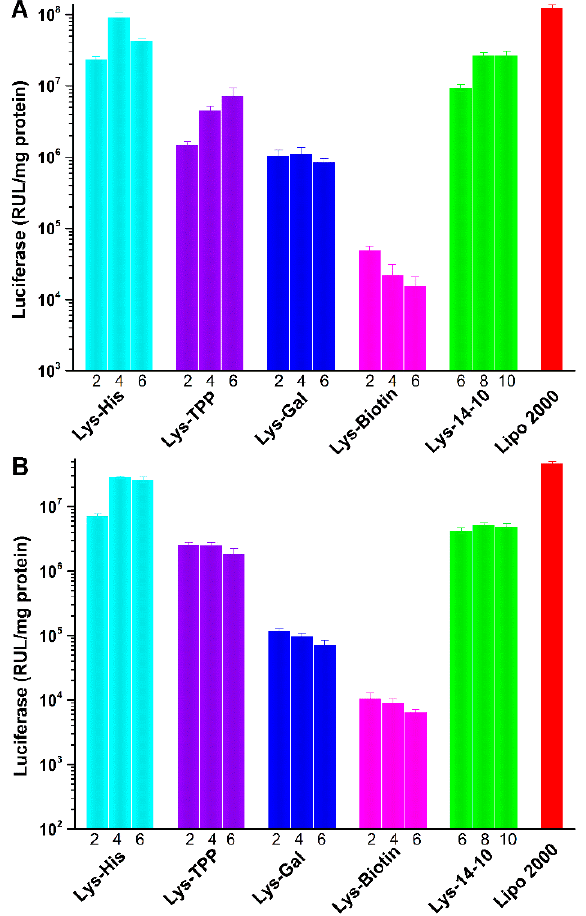
Figure 4. Luciferase expression in HEK 293 ( A ) and HeLa ( B ) cells transfected by bolaplexes at various N/P ratios. Data represent mean ± SD ( n = 3).